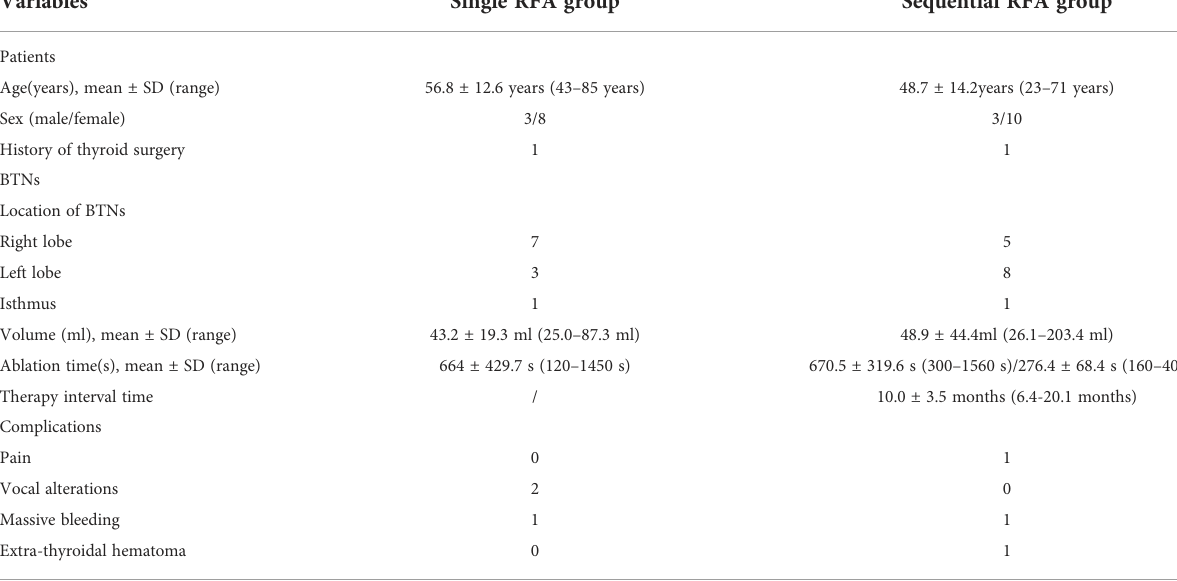
TABLE 2 Characteristics of enrolled patients with large benign solid thyroid